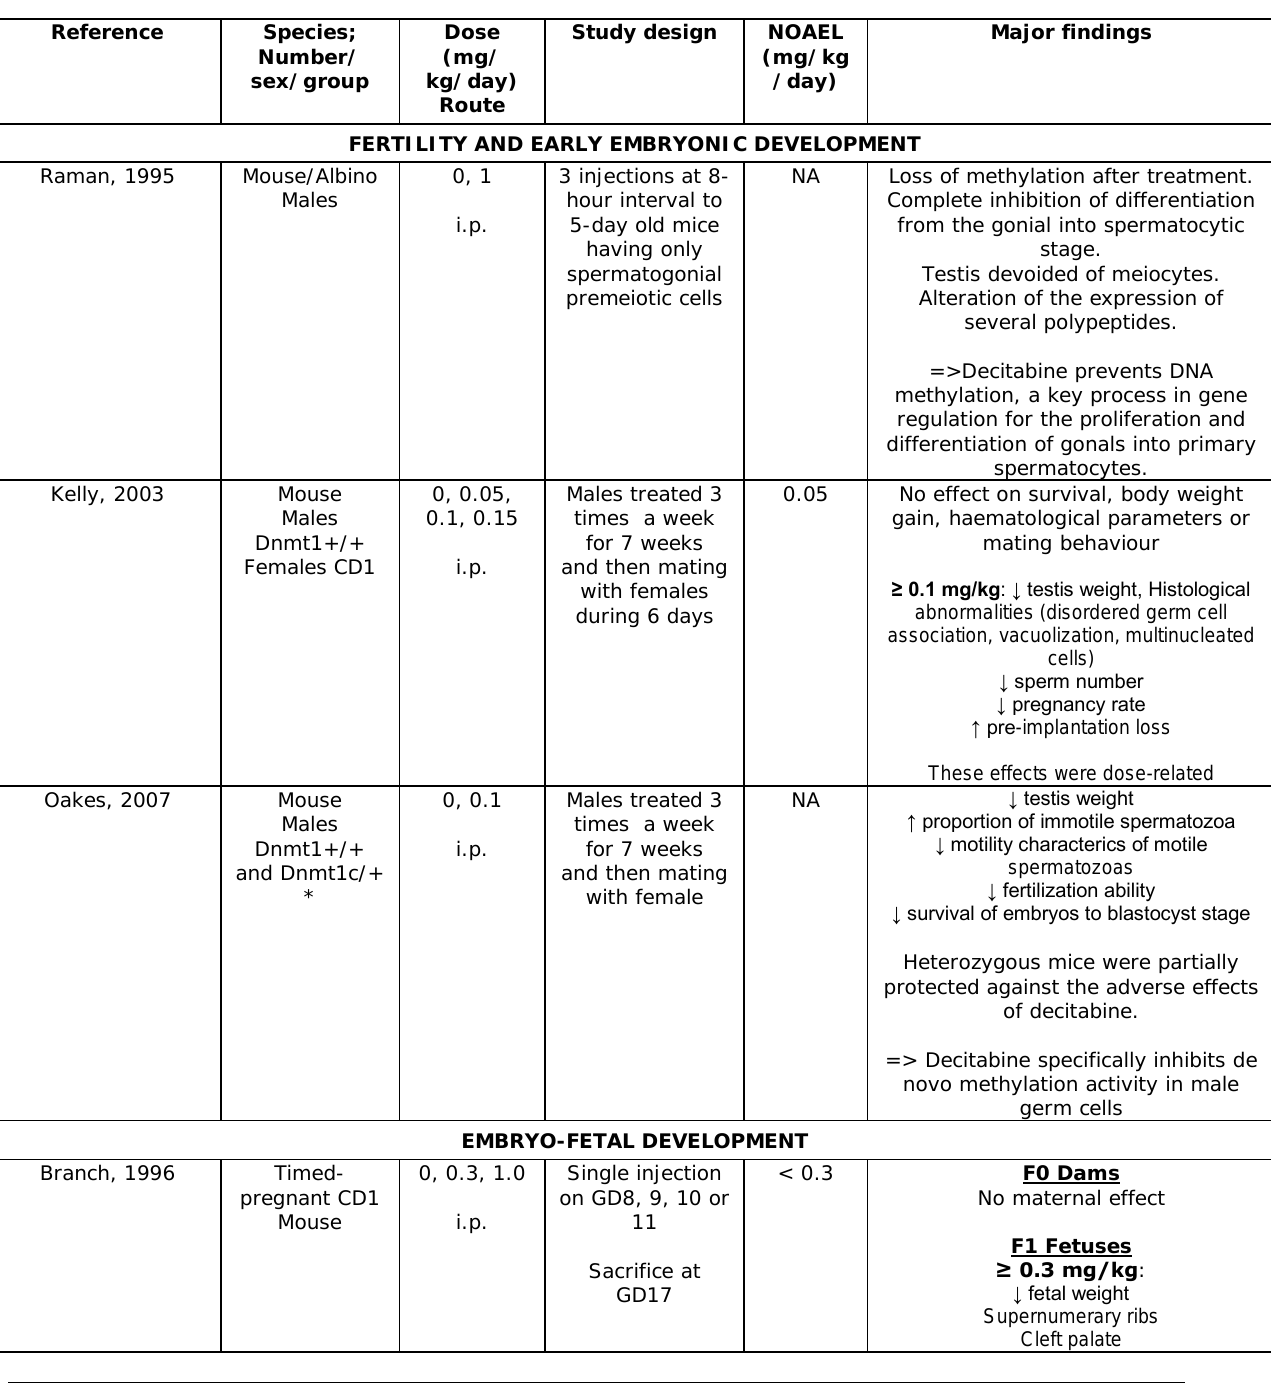
Table 9: Summary of reproductive and developmental